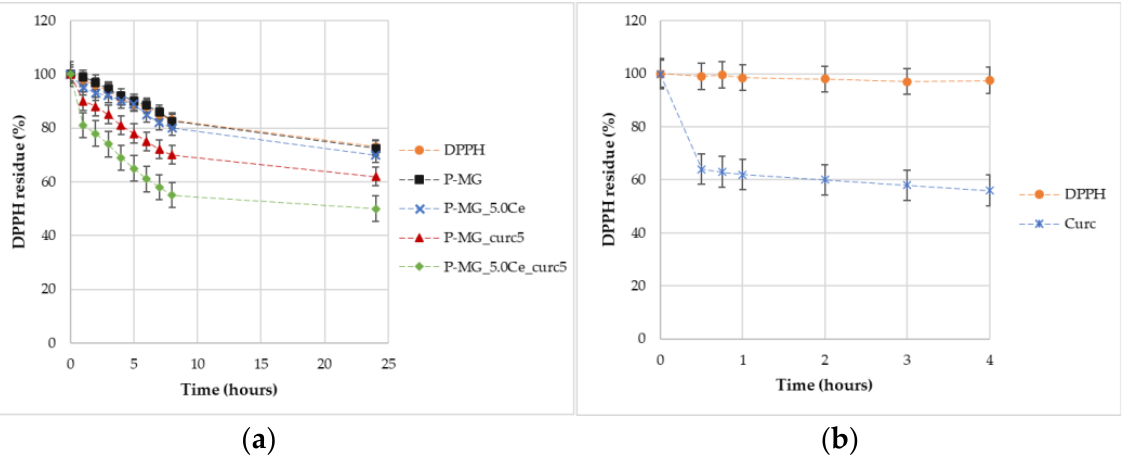
Figure 14. Graphic representation of the percentage of DPPH remaining over time for samples ( a ) and for curcumin effect ( b ).